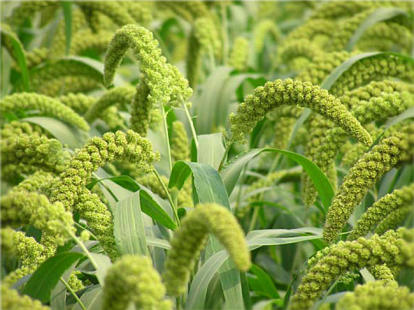
A genome-wide analysis of millet (above) and rice revealed the first clear evidence of horizontal gene transfer in plants